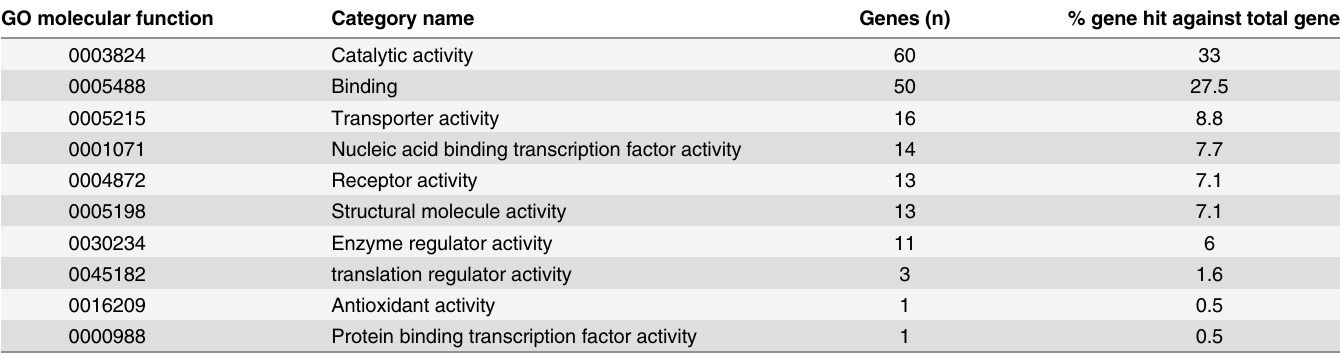
Table 4. Gene-ontology molecular-function categories downregulated in infected cystic-fibrosis cells compared to CTRL cells. GO molecular function